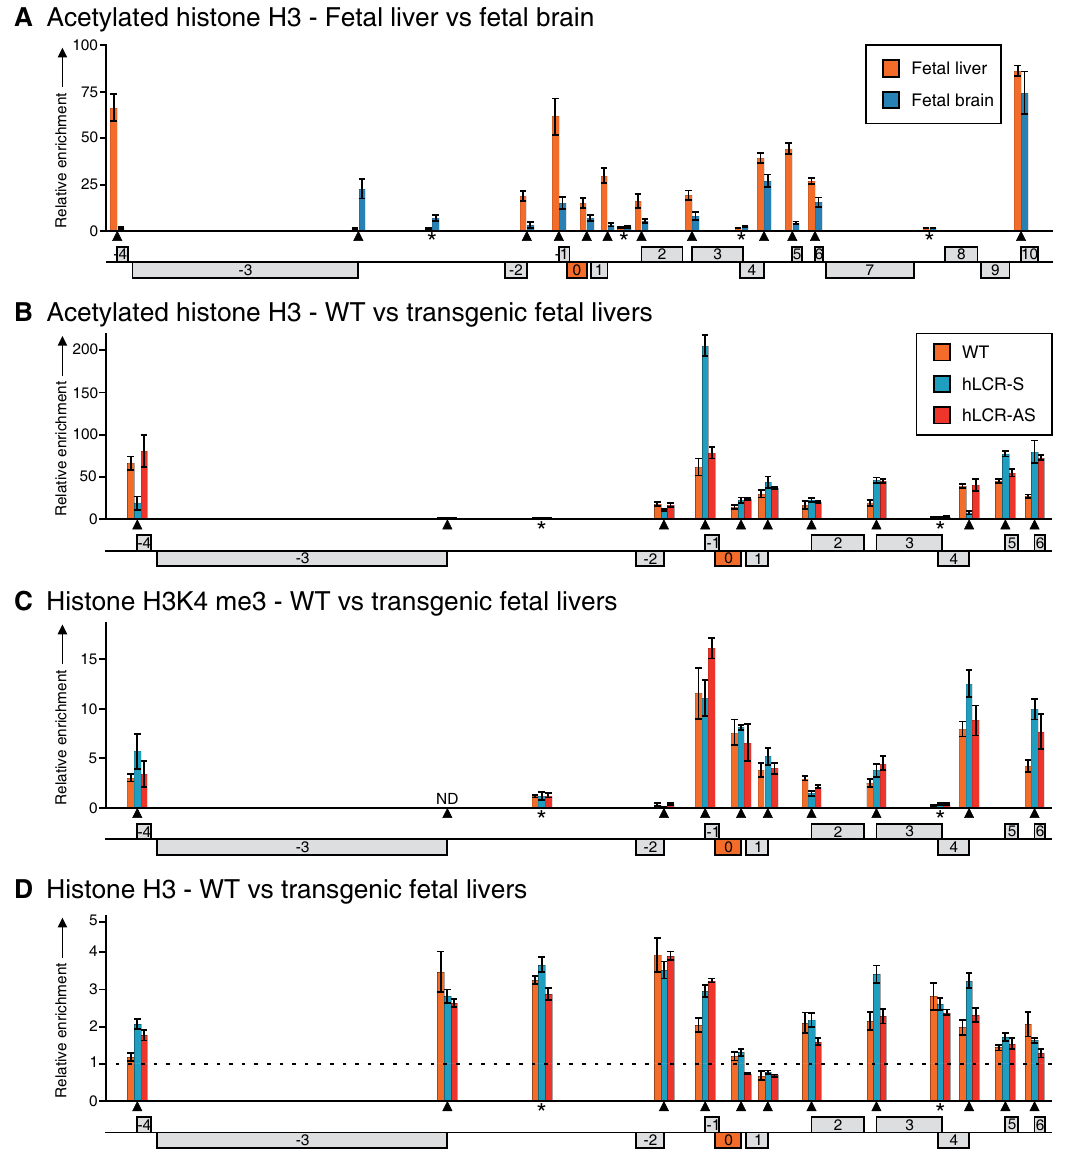
Figure 5. Chromatin organization at 8C3/C4 in the presence of the LCR. (A) Histone H3 acetylation at promoters ( m ) and other regions (*) of 8C3/C4 in WT E14.5 fetal liver and brain as determined by ChIP-analysis. Enrichments were normalized to the Amylase promoter. (B) Histone H3 acetylation at 8C3/C4 in WT and transgenic strains in E14.5 fetal liver. Enrichments were normalized to the Amylase promoter. (C) Histone H3 lysine 4 tri-methylation at 8C3/C4 in WT and transgenic strains in E14.5 fetal liver. Enrichments were normalized to the endogenous b -major promoter. (D) Histone H3 occupancy at 8C3/C4 in WT and transgenic strains in E14.5 fetal liver. Enrichments were normalized to the endogenous b -major promoter. Error bars in all graphs represent standard error (SE) of at least two independent